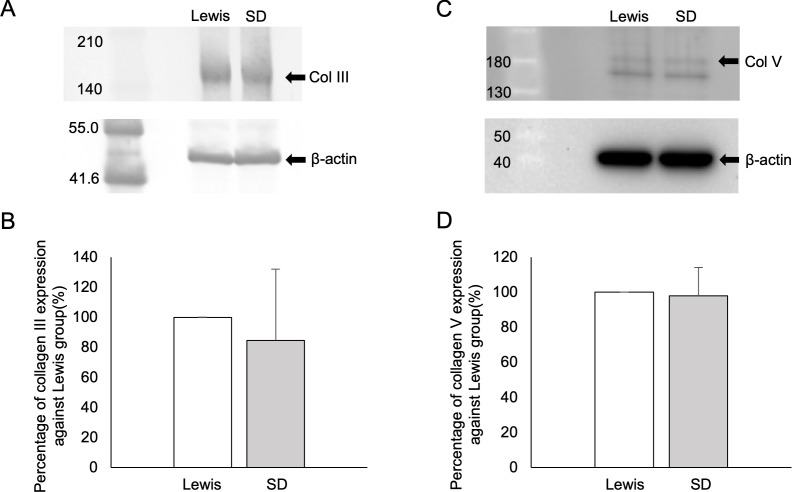
Western blot analyses of Col III (A, B) and Col V (C, D) in the pancreatic tissues of each rat strain. The findings for SD rats are presented as the percentage when those of Lewis rats were considered 100% (B, D). β-actin was used as a control (A, C).